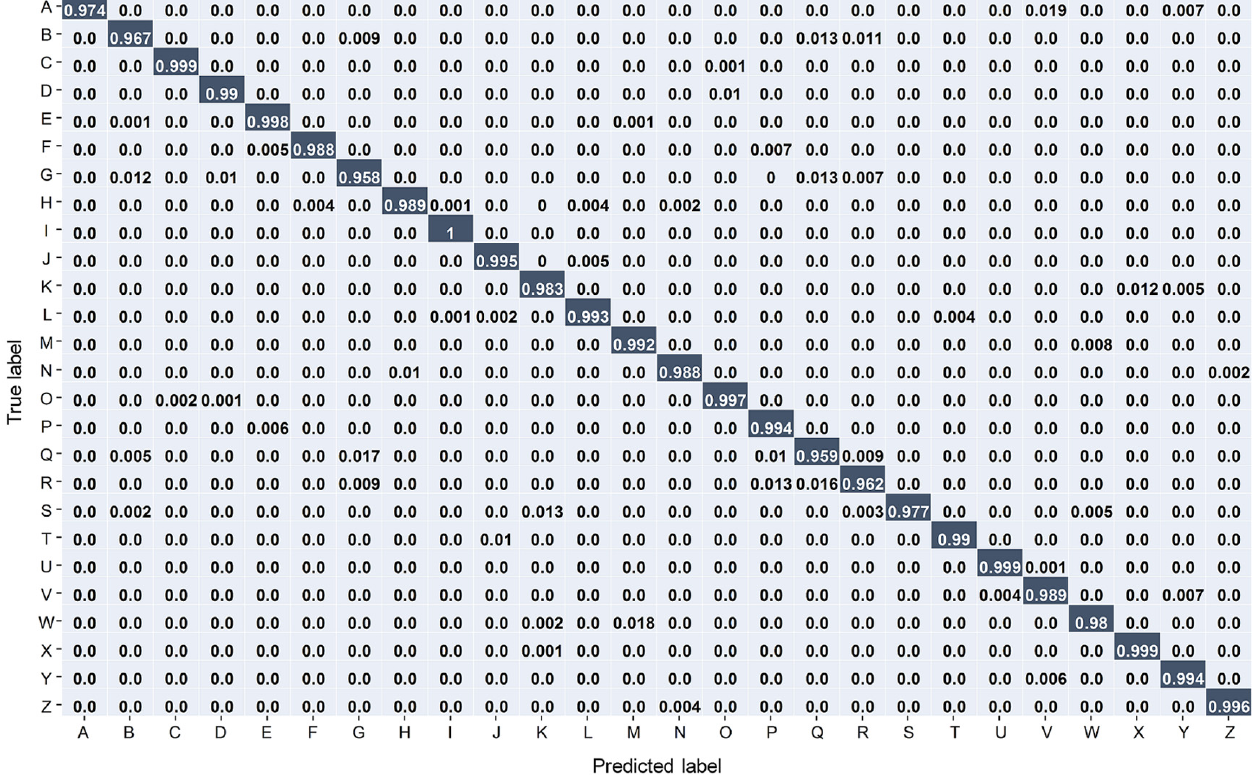
Figure 9. Confusion matrix of MoAS-CNN on 32 × 32 dataset.